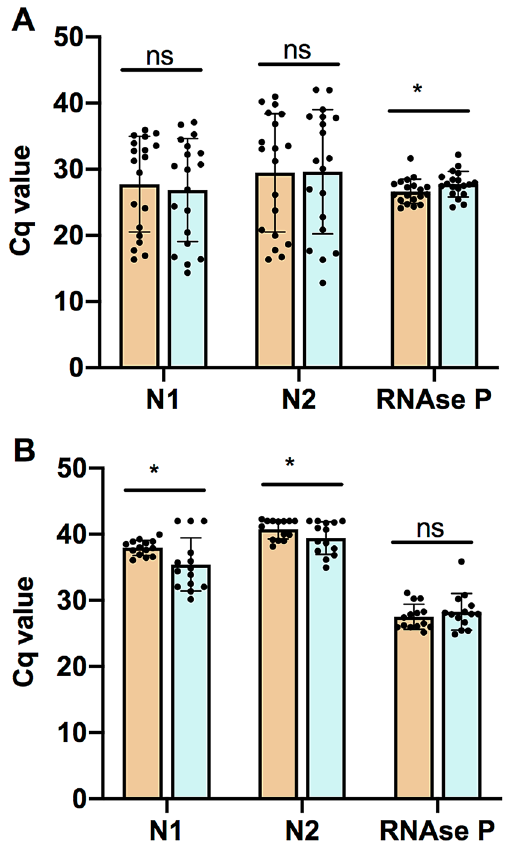
Figure 2. The acid-pH method provides comparable results to commercial kits in clinical samples. Bars represent the mean + /- standard deviation Cq values for each RT-qPCR target gene N1, N2, and RNase P, for samples with Cq N1 ≤ 36 ( A ) and with Cq N1 > 36 ( B ). Each dot represents one sample. Orange bars show results obtained with High Pure Viral RNA Kit (Roche). Blue bars show results obtained with the acid